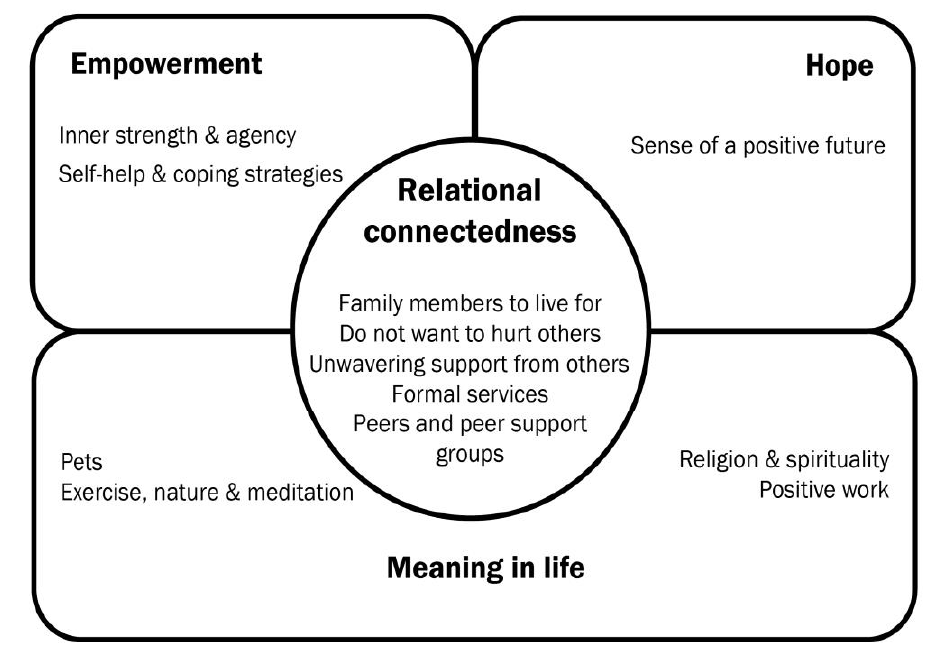
Figure 1. Protective factors mapped to the CHIME framework.